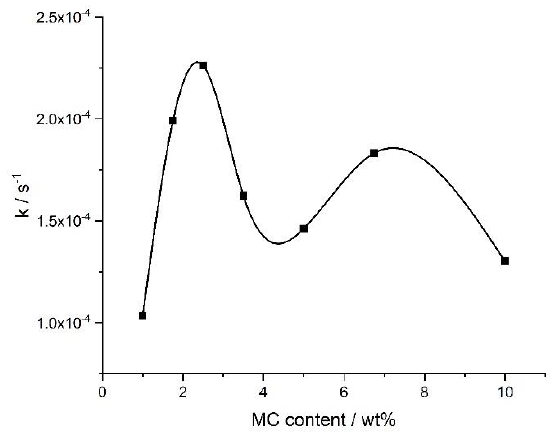
Figure 9. Crosslinking rate, k , determined by DMA, versus the MC content.